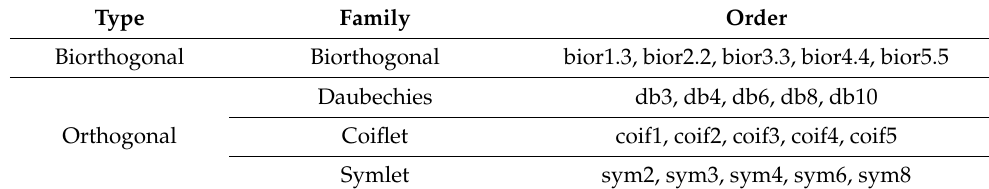
Table 7. Mother wavelet used in this research.